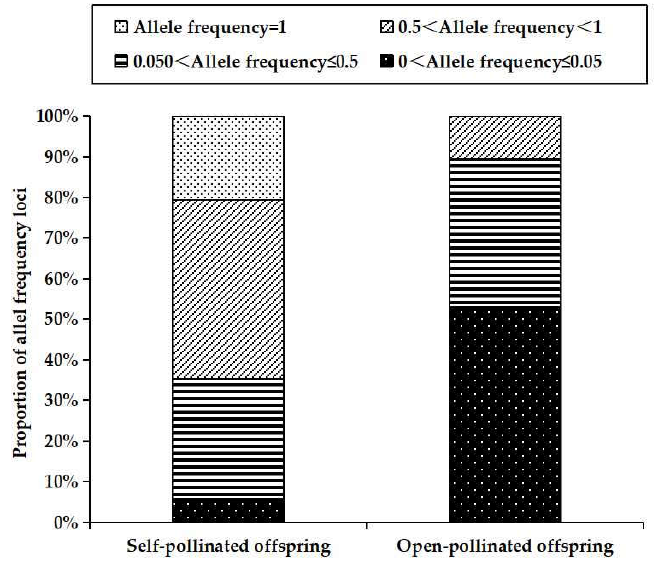
Figure 2. Allele frequency distributions across 20 loci for self- and open-pollinated offspring.